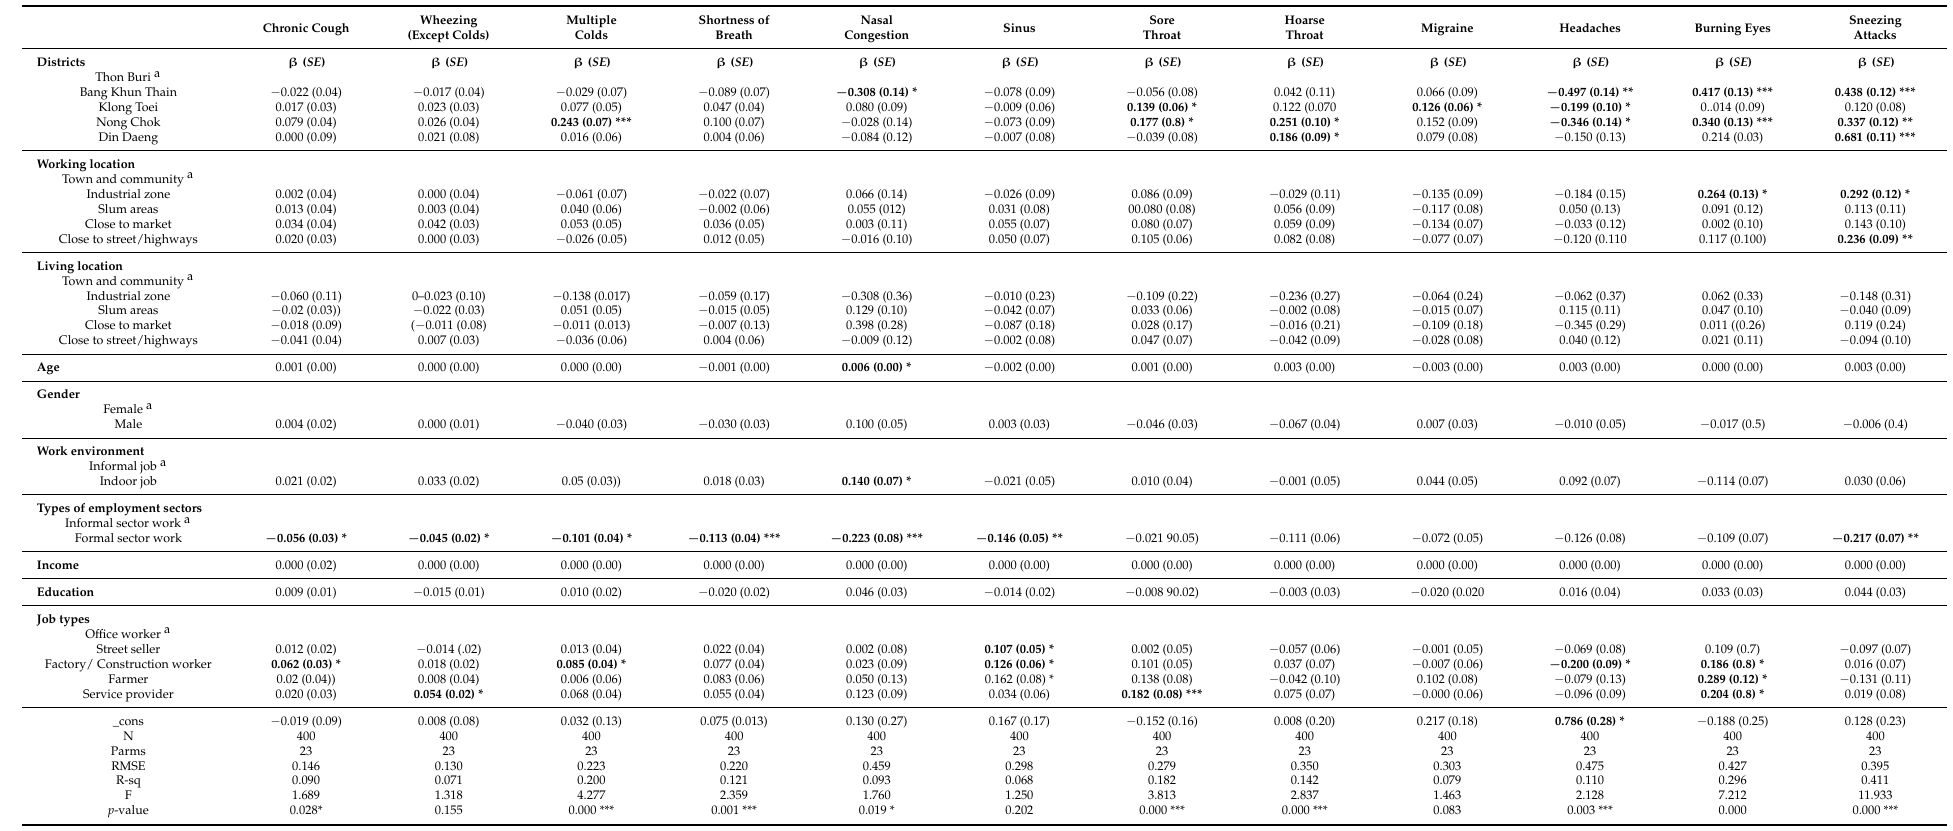
Table 2. Multivariate regression